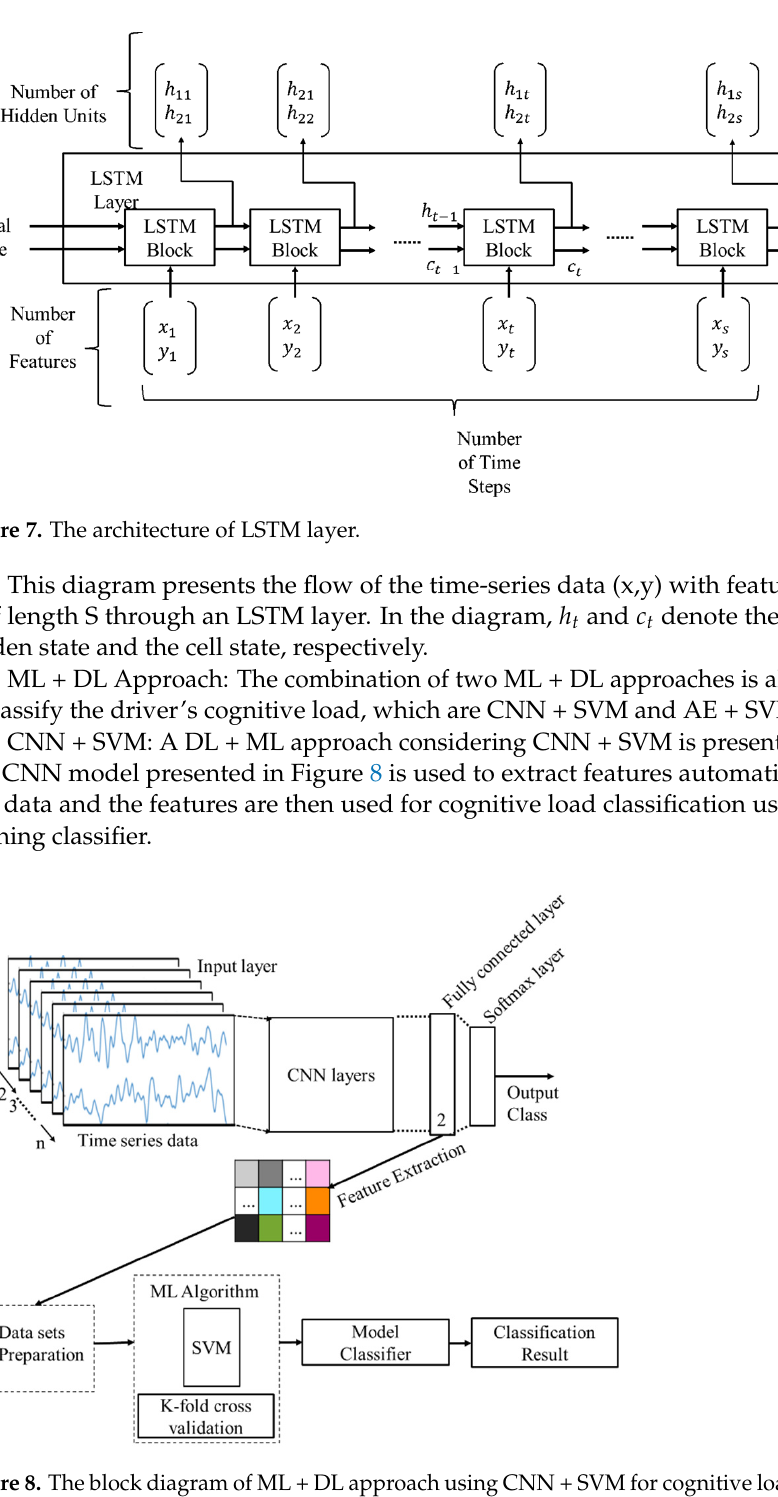
Figure 6. Block diagram of LSTM architecture for the time series classification.